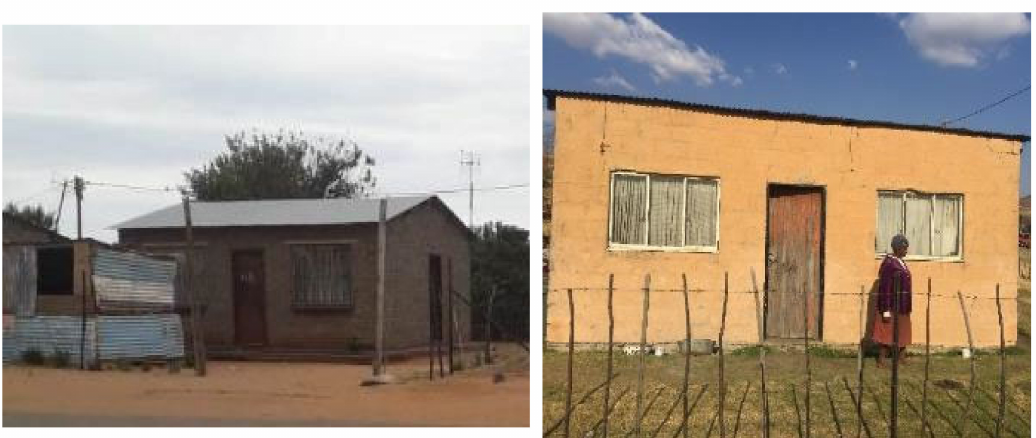
Figure 6. Examples of typical RDP houses in Wakkerstroom; the houses were constructed in late 90’s to early 2000s with maxi brick and corrugated iron roofs (left), and the house at the right is an example of earlier (1994) RDP constructions with asbestos roofing and only one door at the front of the home. The houses had similar dimensions to those found in Kathorus.